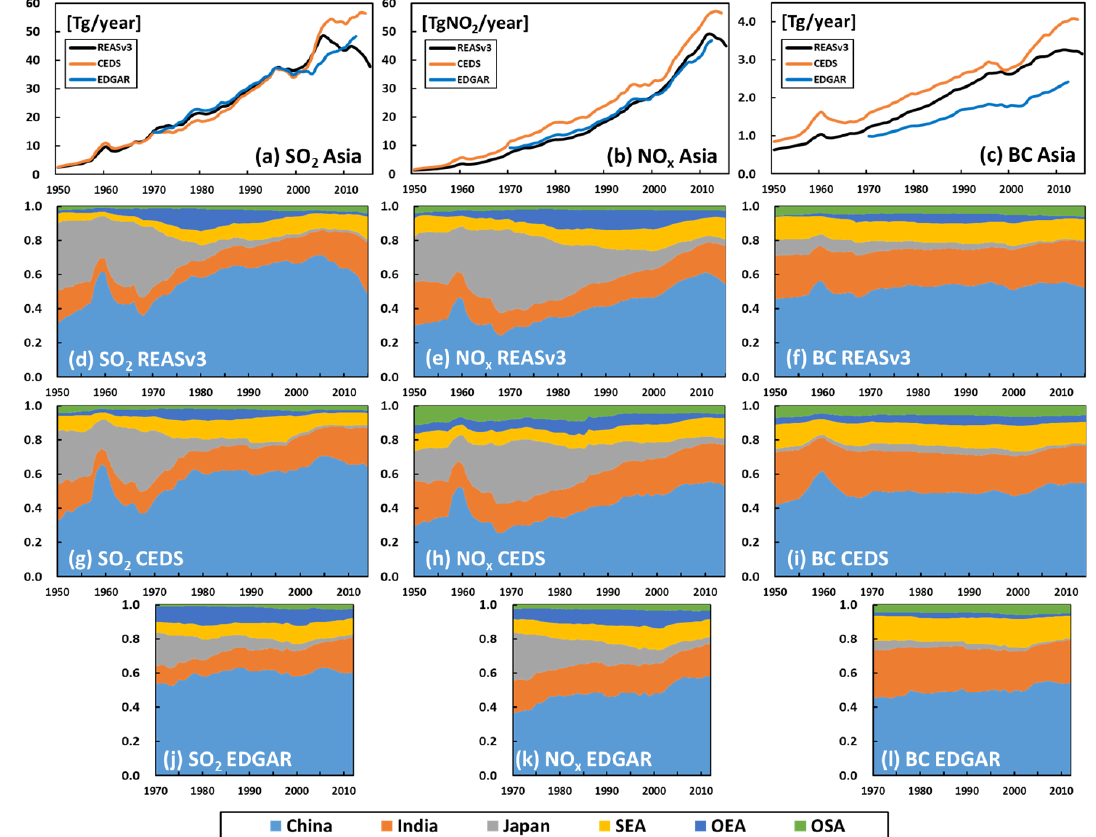
Figure 12. Comparison of trends of (a) SO 2 , (b) NO x , and (c) BC emissions in Asia and relative ratios of emissions from China, India, Japan, SEA, OEA, and OSA for (d, g, j) SO 2 , (e, h, k) NO x , and (f, i, l) BC among (d, e, f) REASv3, (g, h, i) CEDS, and (j, k. l) EDGARv4.3.2. Note that periods of CEDS and EDGARv4.3.2 shown here are during 1950–2014 and 1970–2012, respectively. See Fig. 1 for definitions of SEA, OEA, and